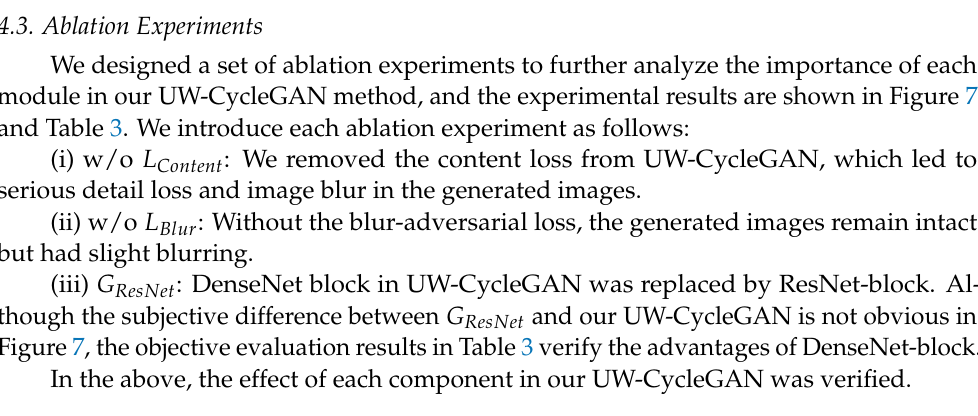
Table 3. Ablation Experiments: Quality evaluation of all methods on URPC